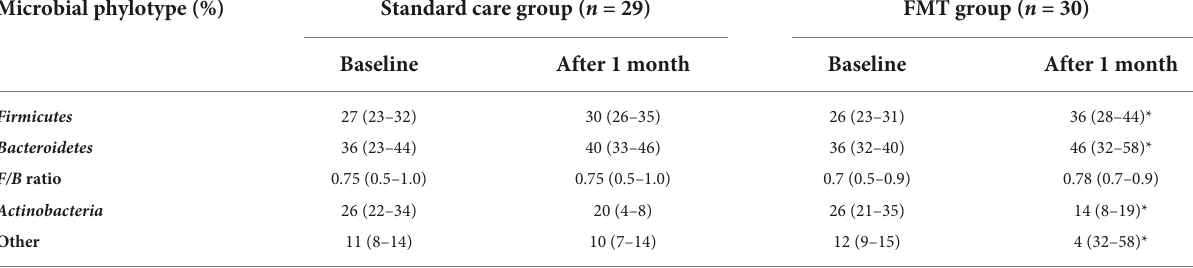
TABLE 5 Contents of the main phylotypes of microorganisms in patients with PI-IBS at baseline and 4 weeks after treatment (%). Microbial phylotype